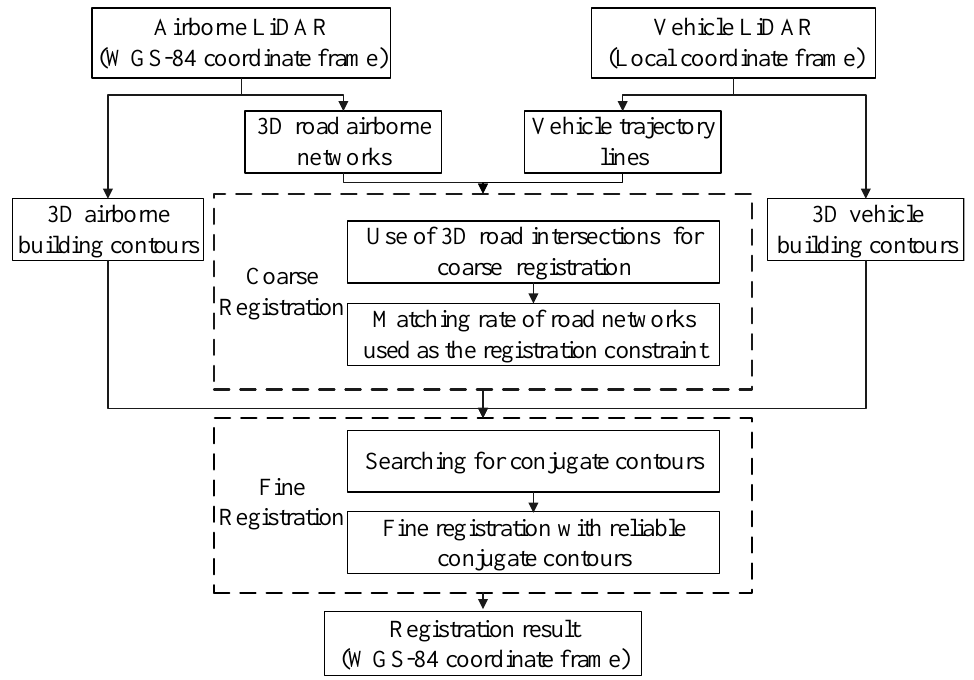
Figure 2. A flowchart of the proposed registration